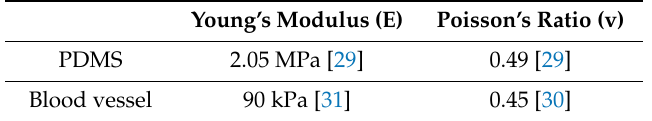
Table 1. Young’s modulus and Poisson’s ratio of the PDMS and the blood vessel.